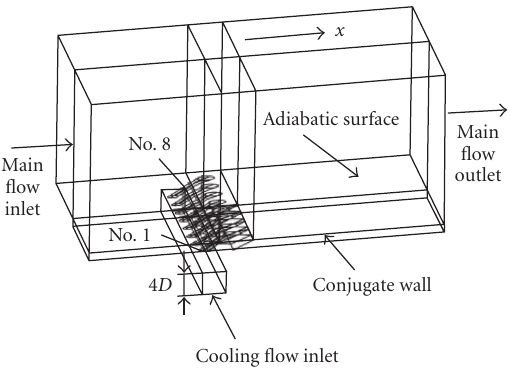
Figure 1: Duct geometry and solution